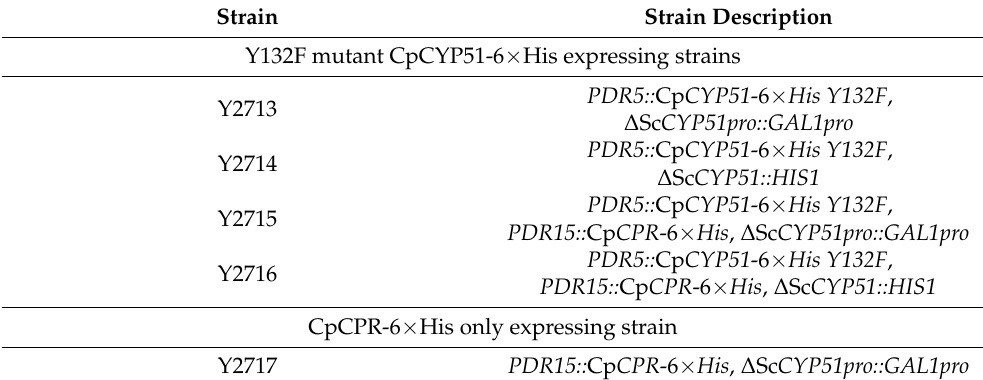
Table 1. Cont . Strain Strain Description Y132F mutant CpCYP51-6 × His expressing